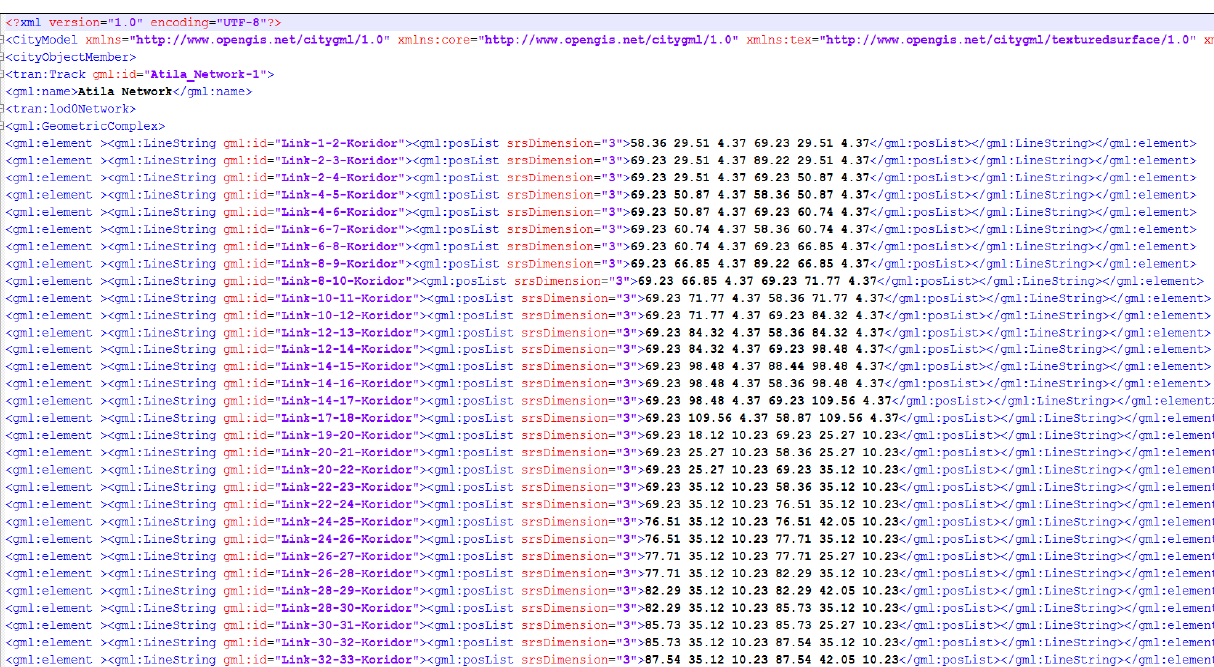
Figure 9. TransportationComplex in LOD0 (Example shows part of a Motorway) (Gröger et al. 2008)